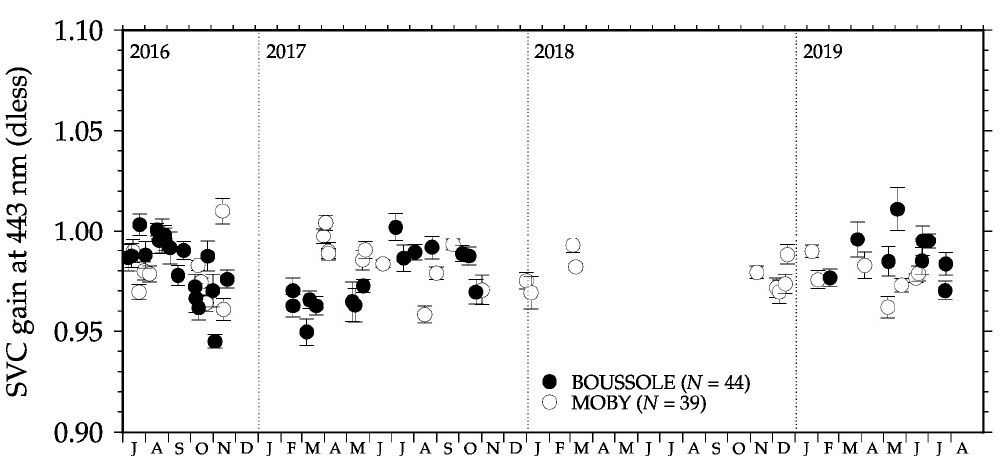
Figure 28. Ocean colour SVC (OC-SVC) gains for Sentinel 3A/OLCI obtained from either BOUSSOLE or MOBY. Dysfunction of both systems plus technical issues delaying the access to S3A data are responsible for the data gap in 2018.